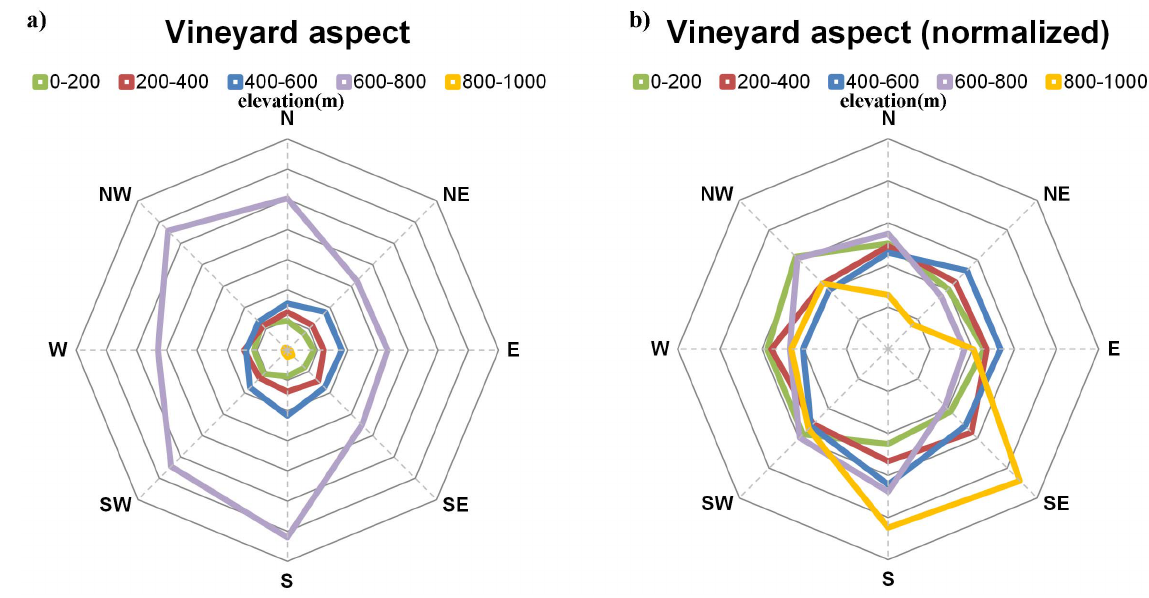
Figure 6. Vineyard aspect in Iberia. a) Geographical aspect (orientation) vineyards in Iberia according to the mean elevation of each DO. b) as in (a) but normalized using the vineyard area.